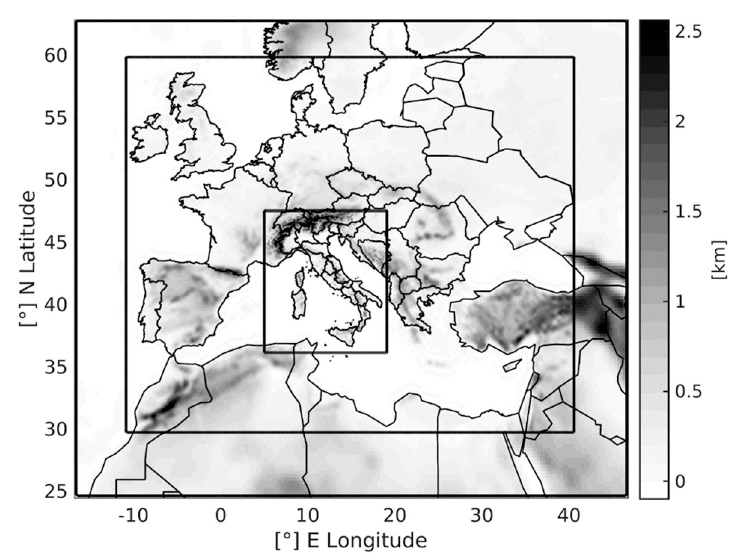
Figure 1. The extent of the three nested domains of the WRF model (22.5, 7.5 and 2.5 km resolution). The elevation is represented using a grayscale colormap.